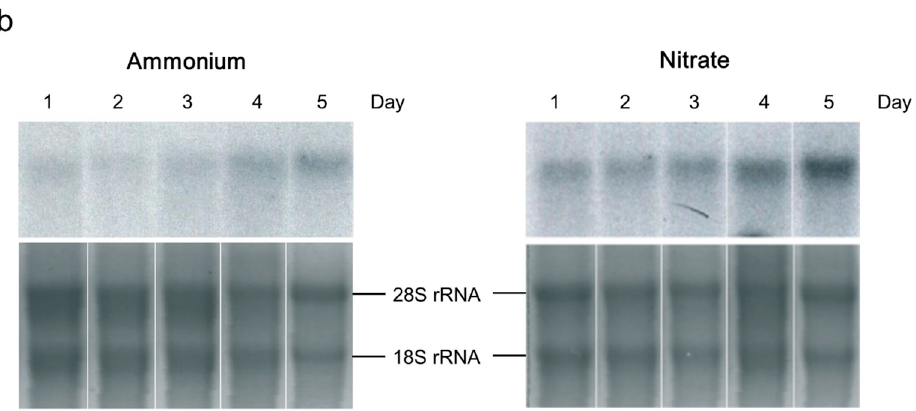
Figure 1. Effect of different nitrogen sources (ammonium vs. nitrate) on aquaporin (AQP) expression in rice ( a ) and French bean plants ( b ). Rice plants were supplied with 2.5 mM ammonium [(NH 4 ) 2 SO 4 ] or nitrate [Ca(NO 3 ) 2 ] for two weeks. Root samples were collected for RNA isolation, and quantitative real-time PCR (q-RT-PCR) was performed to detect the relative expression of the plasma membrane intrinsic proteins (PIPs) and tonoplast intrinsic proteins (TIPs) [60]; ( b ) French bean plants were grown in a split-root system, in which half of the roots were supplied with 5 mM ammonium [(NH 4 ) 2 SO 4 ] or nitrate [Ca(NO 3 ) 2 ]. The PIP1 aquaporin expression in the roots was determined via Northern blot analysis until day 5 after the treatments [59].